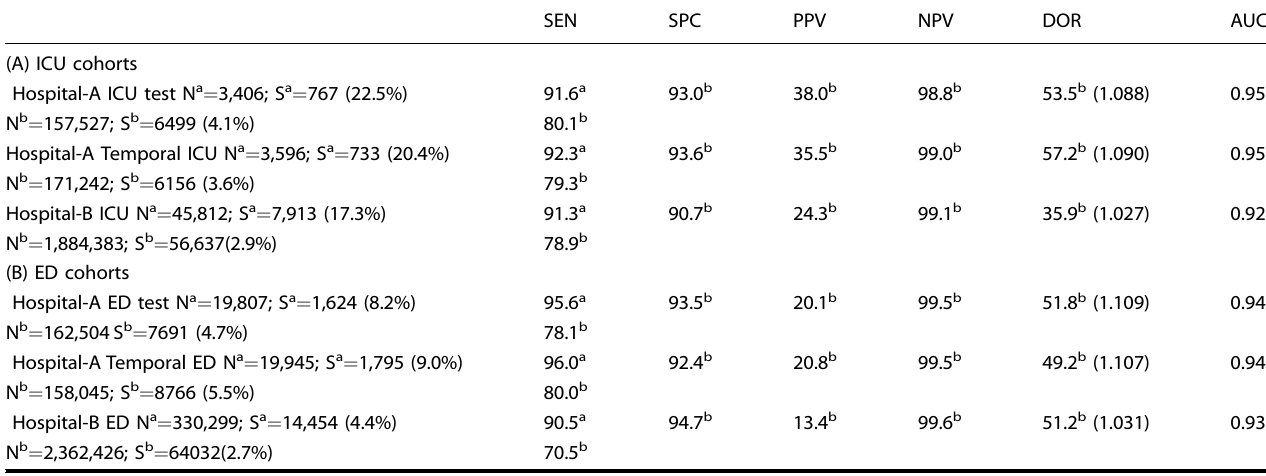
Table 2. Summary of performance of COMPOSER on the (A) ICU and (B) ED cohorts when evaluated in a sequential prediction setting. SEN